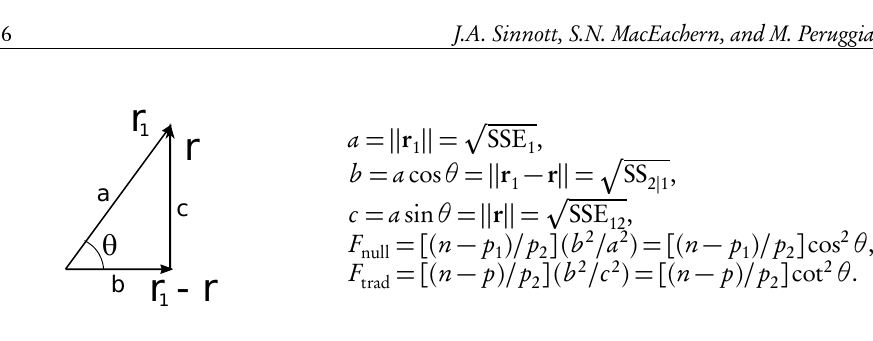
Figure 2 – Geometric representation of the decomposition of the sums of squares for testing a nested hypothesis in the general linear